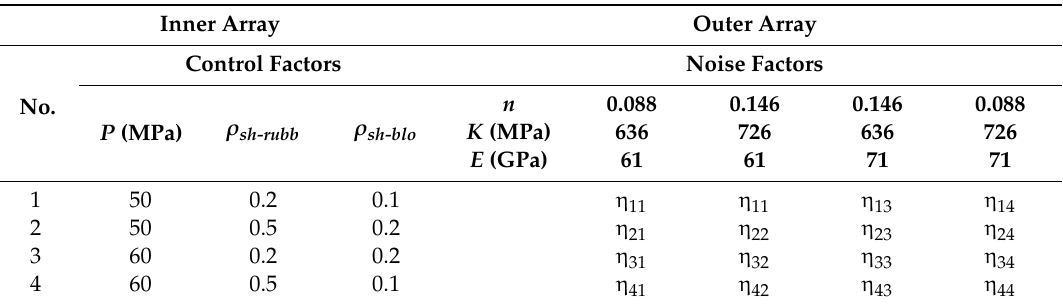
Table 2. Cross array